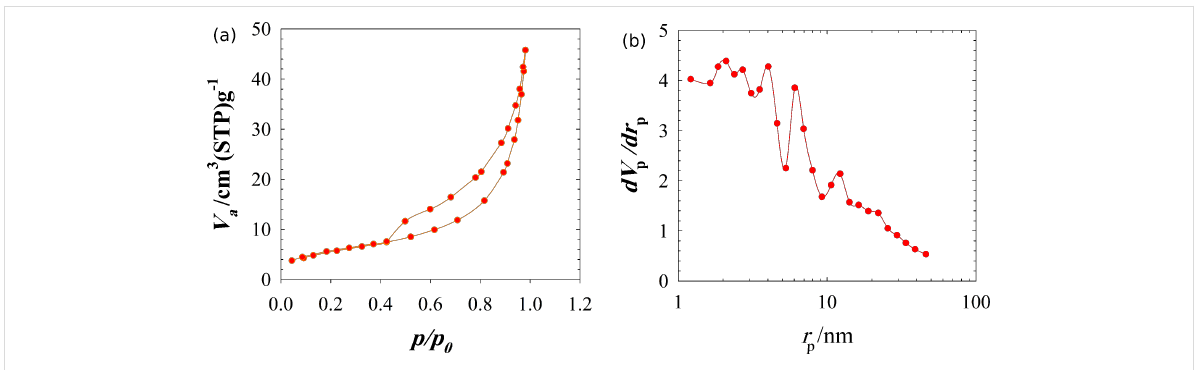
Figure 7: The N 2 adsorption–desorption isotherm (a) and Barrett–Joyner–Halenda (BJH) pore size distribution plot of Cu NPs/bentonite (b).